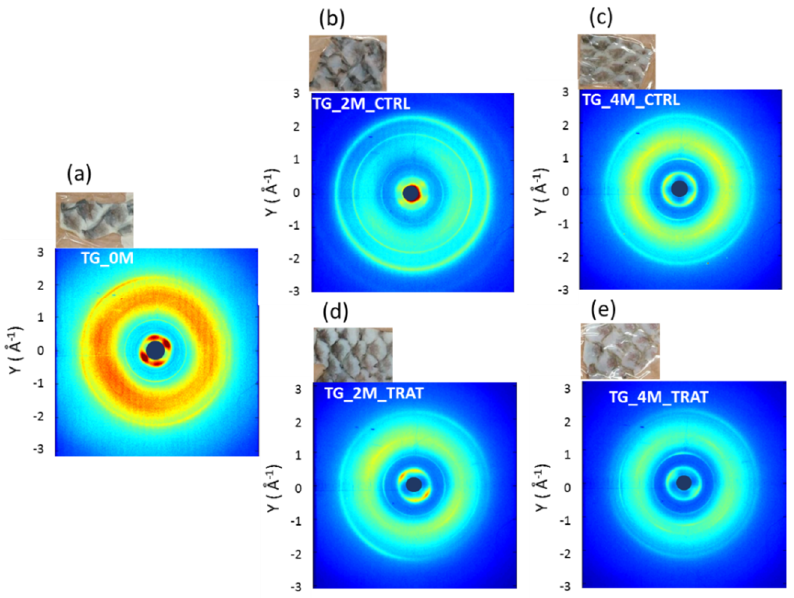
Figure 2. Pictures and 2D WAXS diffraction patterns of Tilapia skin from ( a ) the control fish at time point 0 (TG_0M), fish fed for ( b ) two months (TG_2M_CTRL), and ( c ) four months (TG_4M_CTRL) with conventional feed, fish fed for ( d ) two months (TG_2M_TRAT), and ( e ) four months (TG_4M_TRAT) with collagen nutritional supplementation.